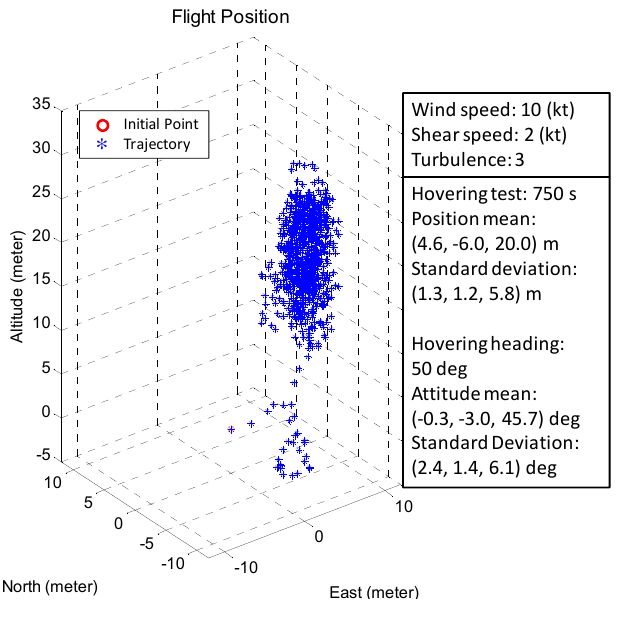
Figure 16. The hovering test result of the FCS under stable weather